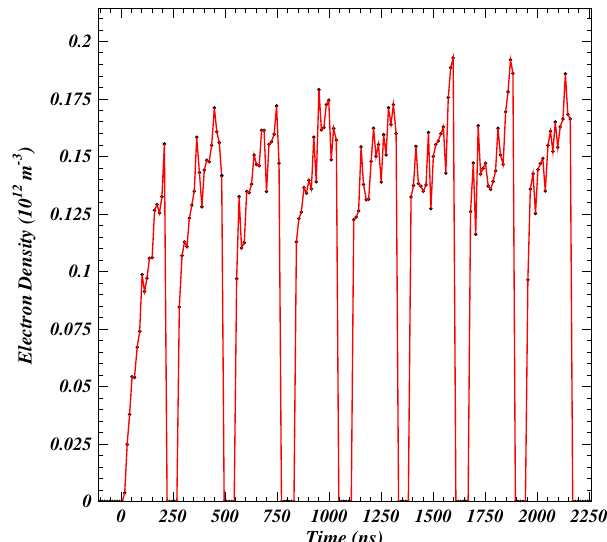
FIG. 10. 20 σ cloud densities on a beam axis just prior to the passage of each of the 34 bunches in 8 trains in a quadrupole magnet in an arc region of the ILC DR. Cloud trapping effects build up over many train passages, but the maximum central density along a train stabilizes at a value less than 2 × 10 11 m − 3 after two trains.